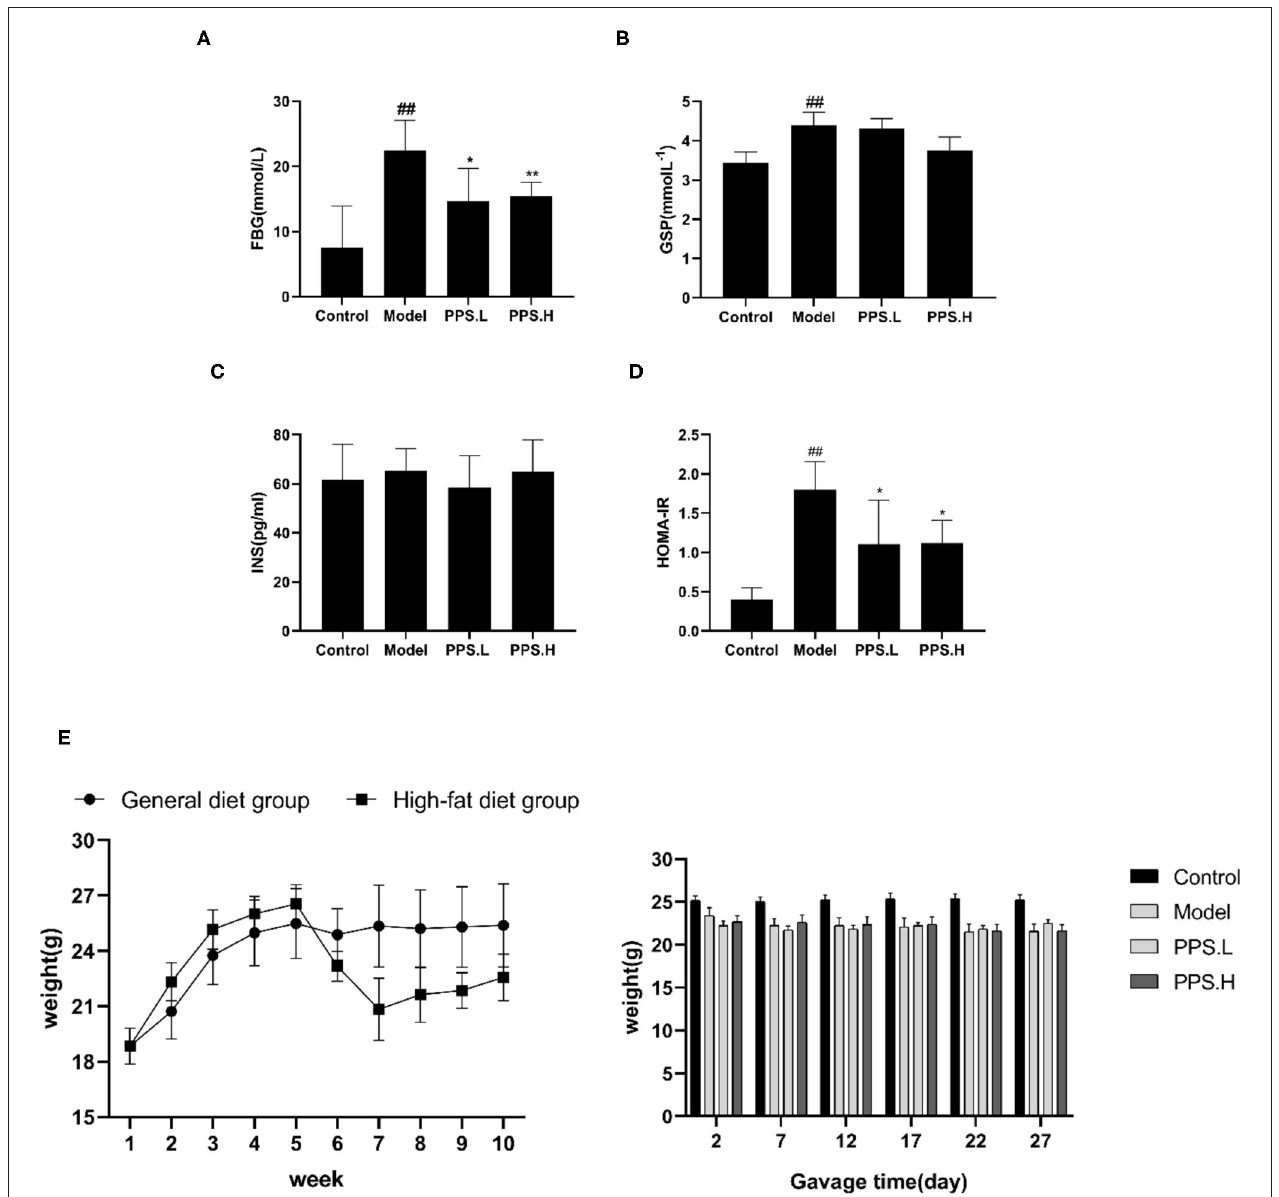
FIGURE 7 | Effect of crude pumpkin polysaccharide on plasma sugar related indexes and weight in mice for 4 weeks. (A) Fasting blood glucose (FBG). (B) Glycosylatedplasma protein (GSP). (C) Insulin (INS). (D) Homeostasis model assessment-insulin resistance index (HOMA-IR). (E) Body weight of mice. Eight mice in each group. Values are expressed as mean ± SD. ## p < 0.01, # p < 0.05 vs. control group; ** p < 0.01, * p < 0.05 vs. model group. PPS.L, pumpkin crude polysaccharide low-dose group (diabetic rats, gavage with W-CCPs at 600 mg/kg b.w.); PPS.H, pumpkin crude polysaccharide high-dose group (diabetic rats, gavage with W-CCPs at 1,200 mg/kg